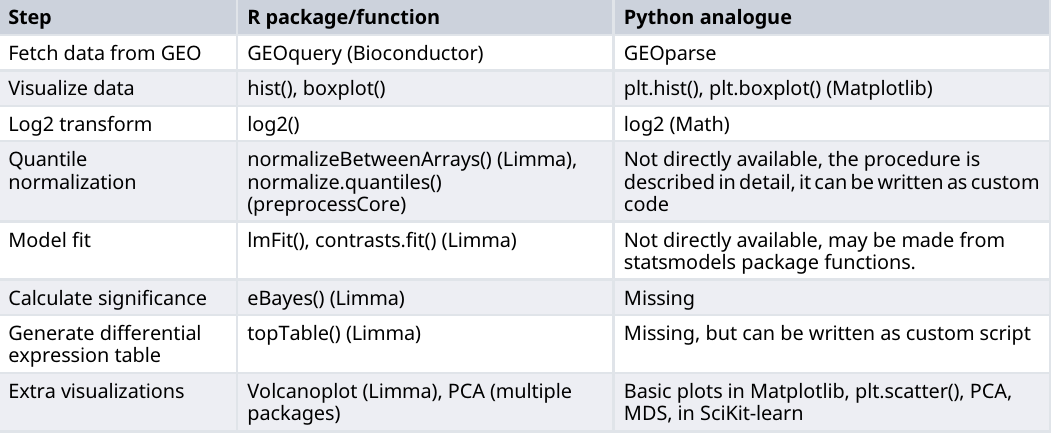
Table 2. Steps and functions for differential expression microarrays analysis in R and analogues in Python. Step R package/function Python analogue Fetch data from GEO